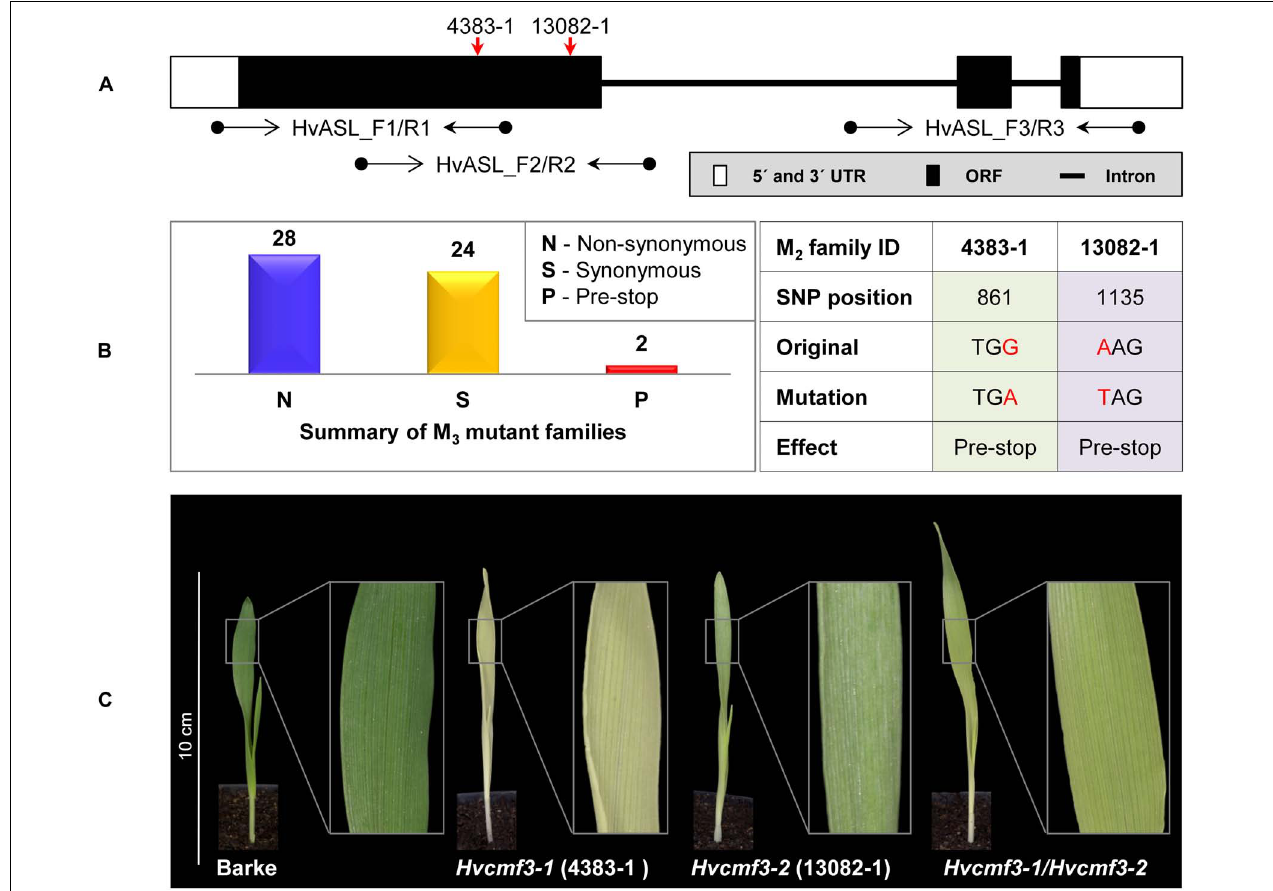
FIGURE 2 | Functional validation of HvCMF3 by TILLING and allelism test. (A) TILLING screening strategy. Screening of coding regions of HvCMF3 by three primer pairs. Red arrows indicate the relative position of the stop codons of TILLING families 4383-1 and 13082-1. (B) Summary of the identified mutations. TILLING screening revealed a total of 54 M 3 mutant families with lesions in the HvCMF3 gene, including 28 non-synonymous, 24 synonymous, and 2 pre-stop mutations. Transition mutation (G to A) at position 861 results in an immature stop codon in family 4383-1. Pre-stop family 13082-1 carries a transversion mutation (A to T) at position 1135. The adenine of the HvCMF3 start codon refers as position 1. (C) Phenotype of Hvcmf3 mutants compared with wild type cv. ‘Barke’ at developmental stage 3 days after germination. Leaves of Hvcmf3-1 mutant exhibit a xantha phenotype. Compared to Hvcmf3-1 , the chlorophyll-deficient phenotype of Hvcmf3-2 mutant is less severe. The F 1 hybrid, Hvcmf3-1/Hvcmf3-2 derived from crossing 4383-1 × 13082-1, exhibits a pale green